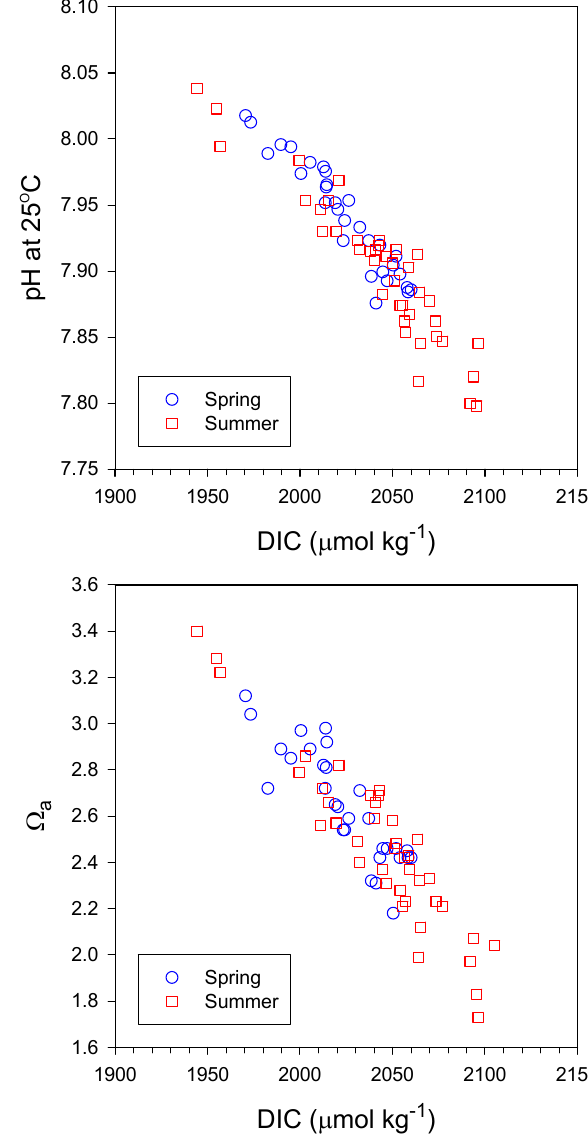
Fig. 11. Plots of (a) pH 25 vs. DIC and (b) (cid:127) a vs. DIC for the bottom waters in the East China Sea during spring and summer